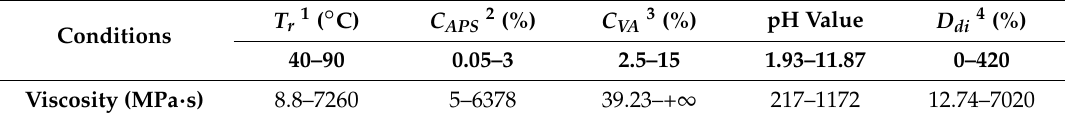
Table 2. The range of viscosity values of PVAc.